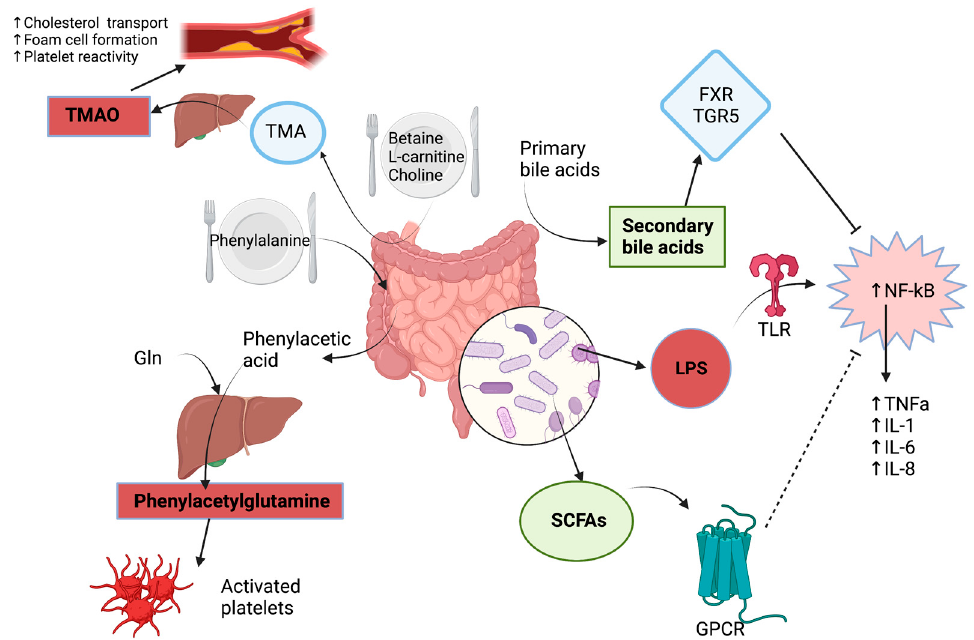
Figure 1. Major metabolic pathways involving the gut microbiome and leading to the development and progression of atherosclerotic cardiovascular disease. FXR: farnesoid X receptor, Gln: glutamine, IL-1: interleukin-1, IL-6: interleukin-6, IL-8: interleukin-8, LPS: lipopolysaccharides, NF- κ B: nuclear factor- κ B, SCFAs: short-chain fatty acids, TGR5: takeda G protein-coupled receptor 5, TLR: toll-like receptor, TMA: trimethylamine, TMAO: trimethylamine N-oxide, TNF- α : tumor necrosis factor- α .